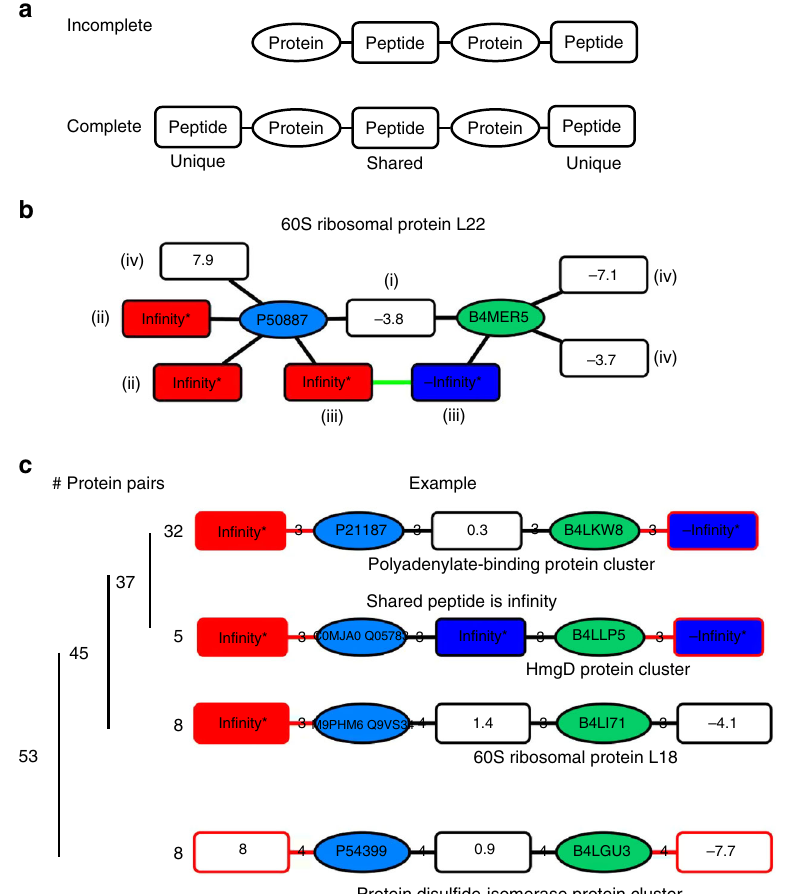
Fig. 3 Quanti fi cation of relative protein abundance in a peptide-to-protein cluster and classi fi cation of complete protein pairs based on ratio measurements. a Schematic of an incomplete and a complete protein pair. Peptide nodes are displayed as rectangles and protein nodes are ellipses. b The peptide-to- protein cluster of the D . melanogaster (P50887, blue ellipse) and D . virilis (B4MER5, green ellipse) orthologs of 60S ribosomal protein L22 (RpL22) is depicted. The relative peptide abundance (Rc) is indicated in each peptide node: (i) denotes peptides that are shared by two different protein nodes; (ii) and (iii) highlight peptides that are present exclusively in one sample (unique peptide nodes). The expected ratio value is n :0 or log 2 ( n /0) = + ∞ for a D . melanogaster -speci fi c peptide (light isotope label, red rectangles) or 0: n or log 2 (0/ n ) = − ∞ for a D. virilis -speci fi c peptide (heavy isotope labels, green rectangles). The two-species-speci fi c peptides (iii) are connected by an additional edge in green to indicate ≥ 80% sequence similarity (Supplementary Methods and Note 7). Species-speci fi c peptides that were measured with a ratio value, although an in fi nity value is expected, are indicted with (iv). c Four different groups of protein pairs are shown. Each group subsumes protein pairs with similar ratio values for the unique as well as shared peptide nodes. Edges and nodes rendered in red indicate that this peptide node is signi fi cantly regulated within the protein pair (protein pair-centric analysis, see below). The number of protein pairs identi fi ed for each classi fi cation is indicated on the left as well as a brief description for each group is given in italic. One example for each group is